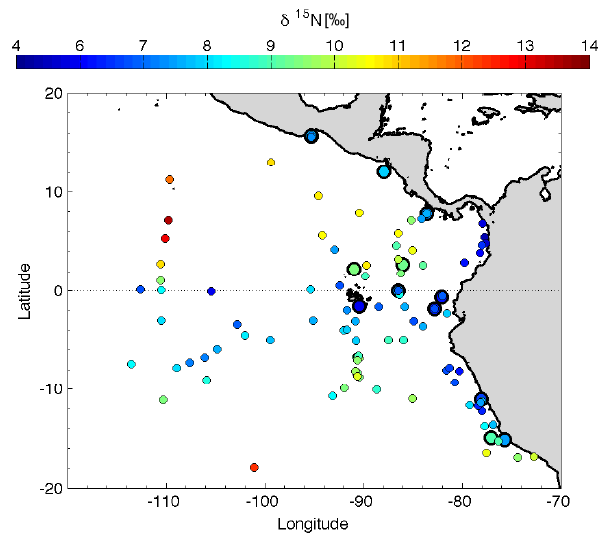
Fig. 5. Locations of sediment core sites (large circles) and surface samples (smaller circles) in the eastern equatorial Pacific. The large circles approximately encompass the spatial range of a 100km ra- dius. All surface samples that fall within that range are averaged and compared to the LH average of the core